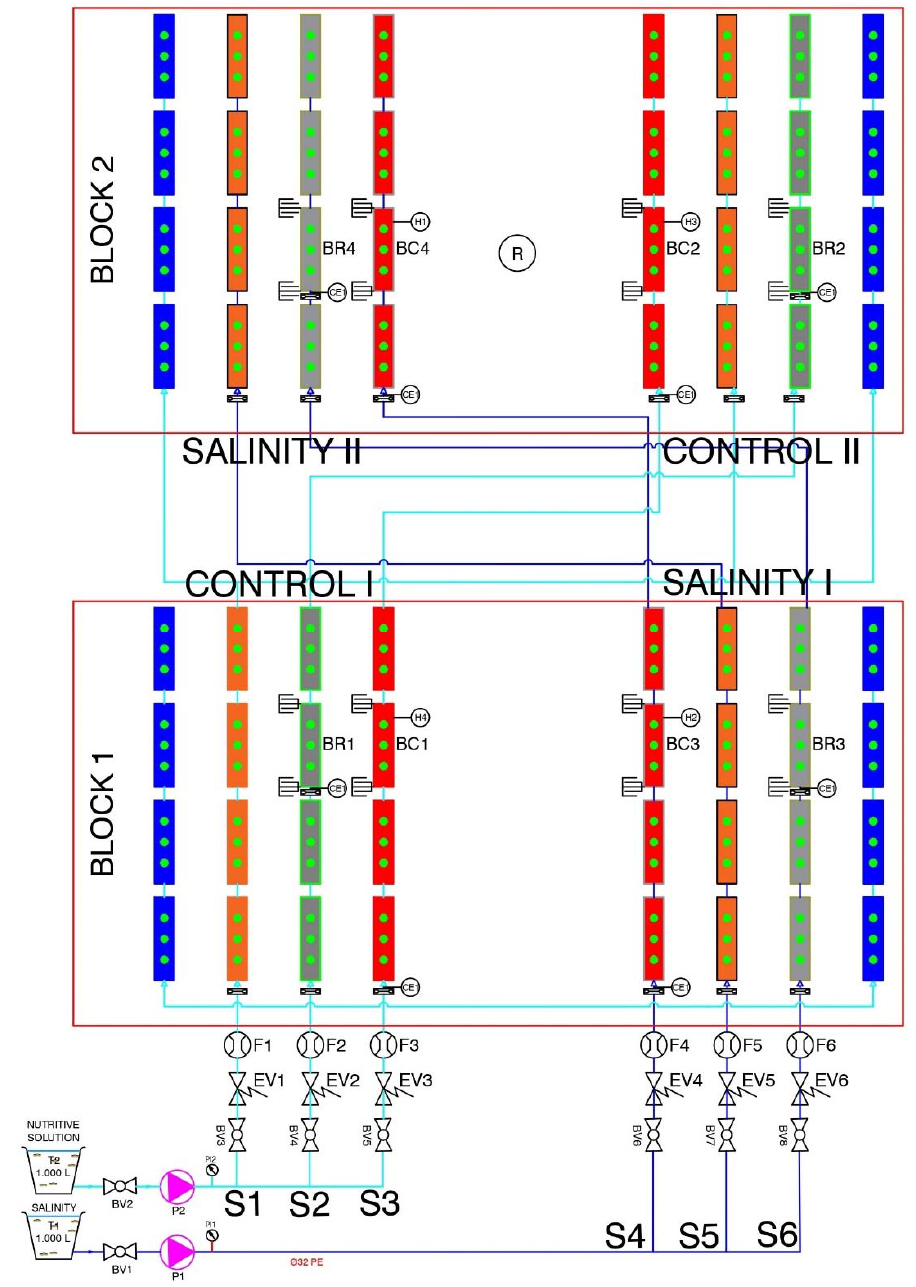
Figure 1. Scheme of the experimental design. Two saline treatments were factorially combined with 3 control systems. Accumulated solar radiation (AR) treatments S1 and S5 are in orange, Gravimetry (G) S2 and S6 in grey, and Volumetric Water Content (VWC) S3 and S4 in red.